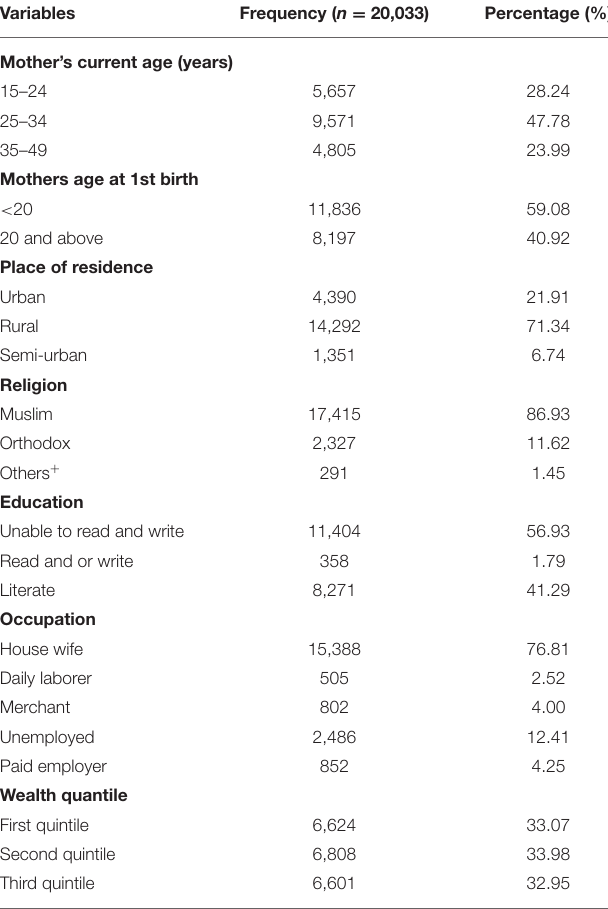
TABLE 1 | Socio-demographic characteristics of the mothers in Kersa HDSS from 2015 to 2020.